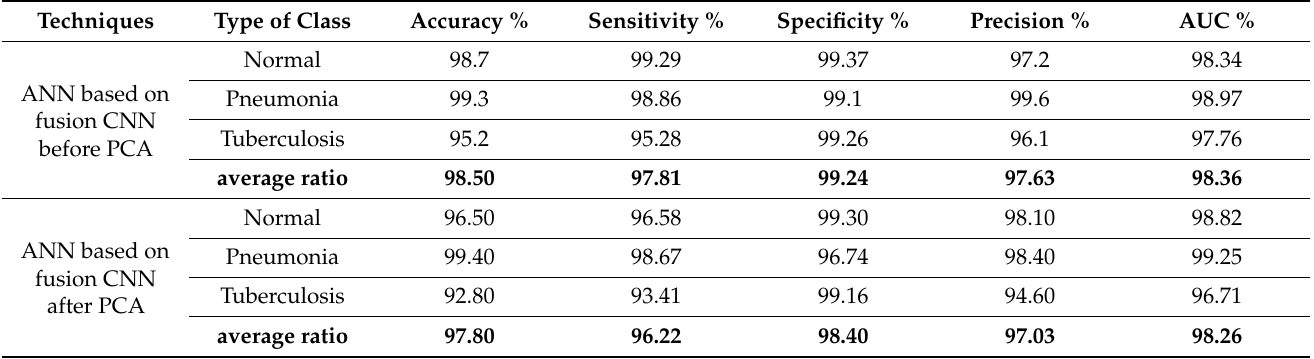
Table 4. Results of the ANN network based on fused features between the VGG16 and ResNet18